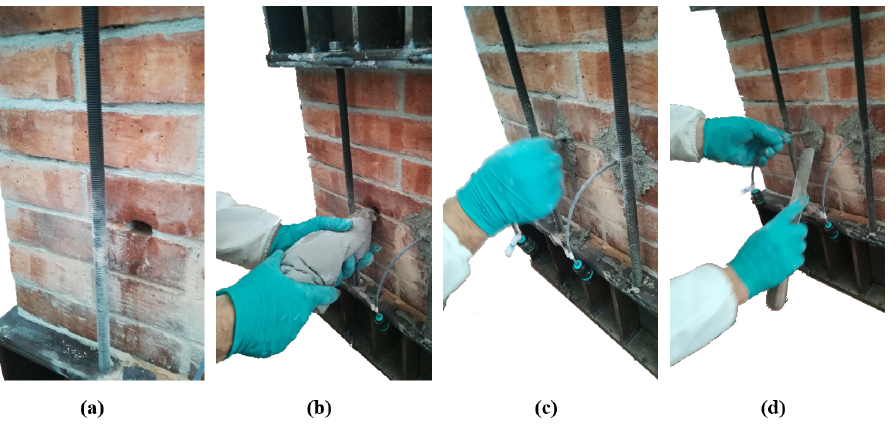
Figure 4. Operating phases for the first post-installation system (P1) of the sensors: ( a ) hole drilling; ( b ) hole filling by using mortar; ( c ) sensor placement; ( d ) hole sealing. The second post-installation system (named P2) is more complex and